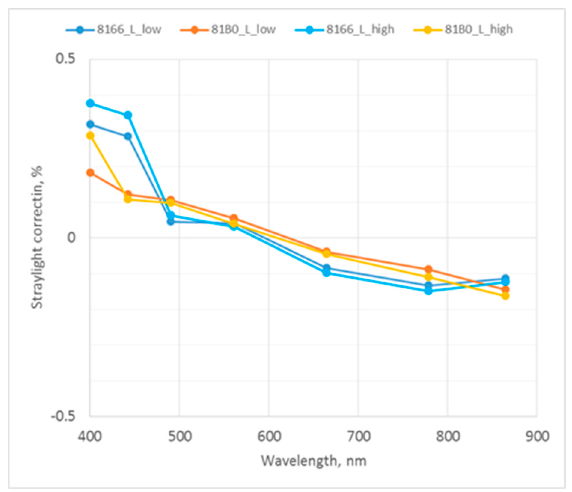
Figure 15. Stray light effects for indoor radiance measurements. Two RAMSES radiance sensors at high and low sphere radiance.